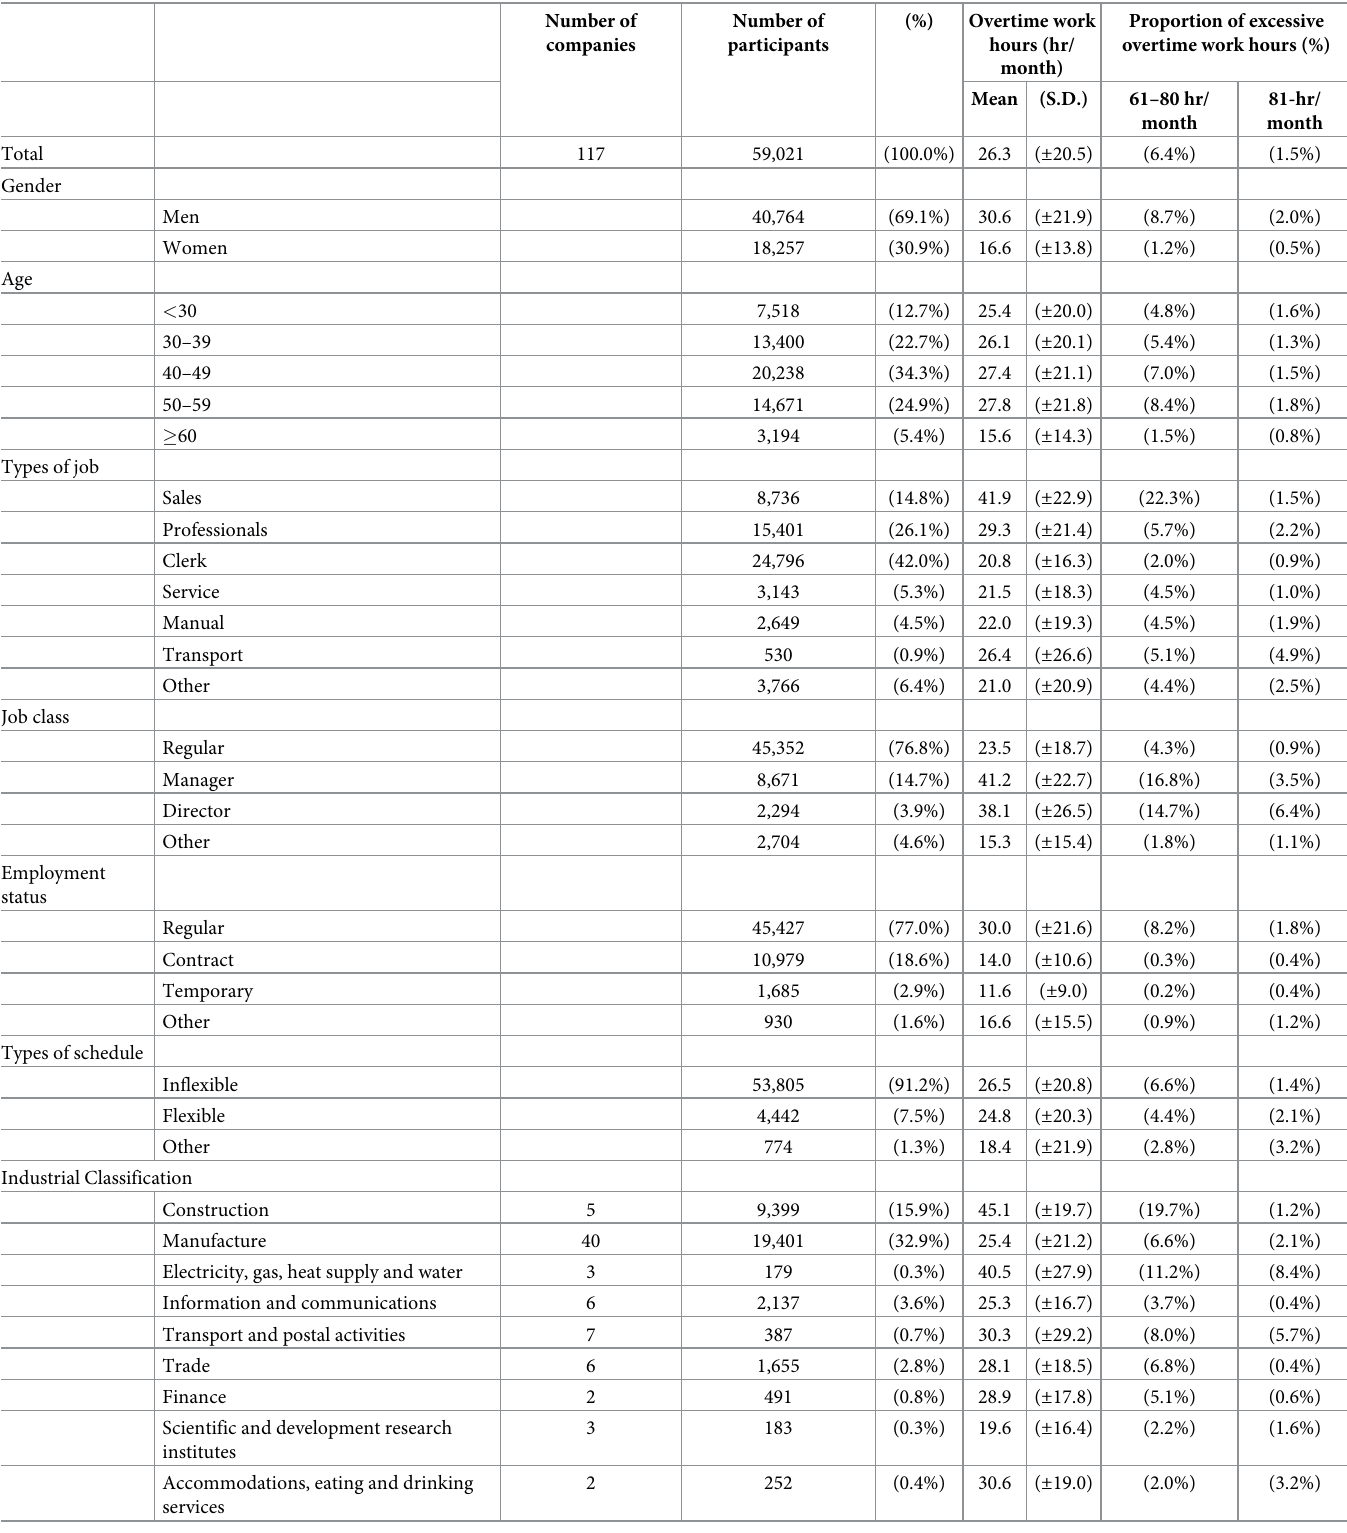
Table 1. Characteristics of